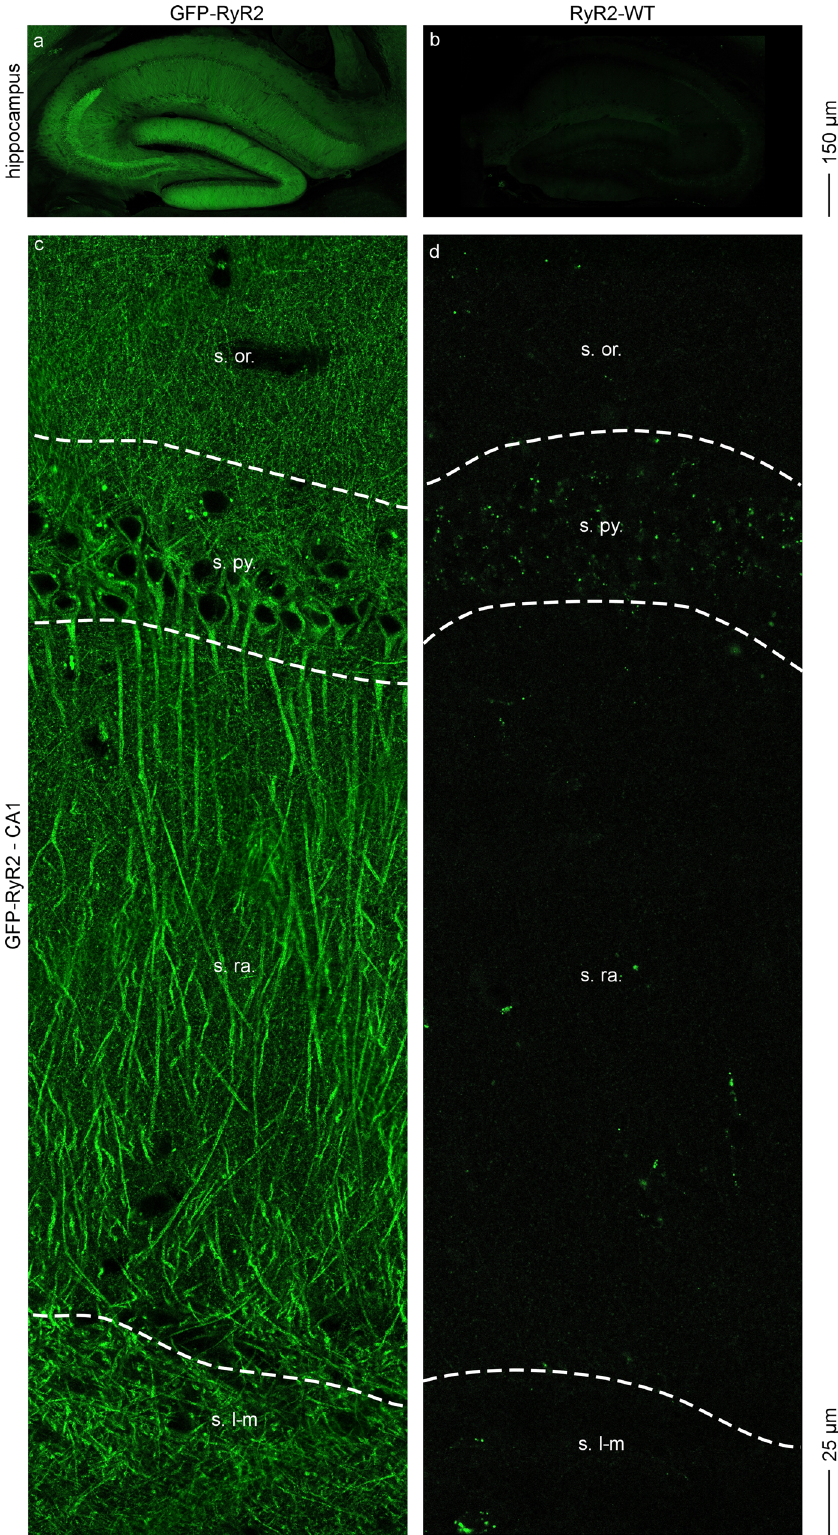
Fig. 2 Confocal imaging of live hippocampal slices from GFP-RyR2 and non-GFP RyR2 WT mice. Representative confocal GFP fl uorescence images of live hippocampal slices from mice expressing the GFP-tagged RyR2 ( a , c ) and non-GFP RyR2 WT mice ( b , d ). Images of the whole hippocampal area of the GFP-RyR2 ( a ) and WT ( b ) brains. Magni fi ed view showing the stratum oriens (s. or.), stratum pyramidate (s. py.), stratum radiatum (s. ra.), and stratum lacunosum-moleculare (s. l-m) areas of the CA1 region in GFP-RyR2 ( c ) and WT ( d ) live hippocampal slices ( n = 9 images from three brains for each